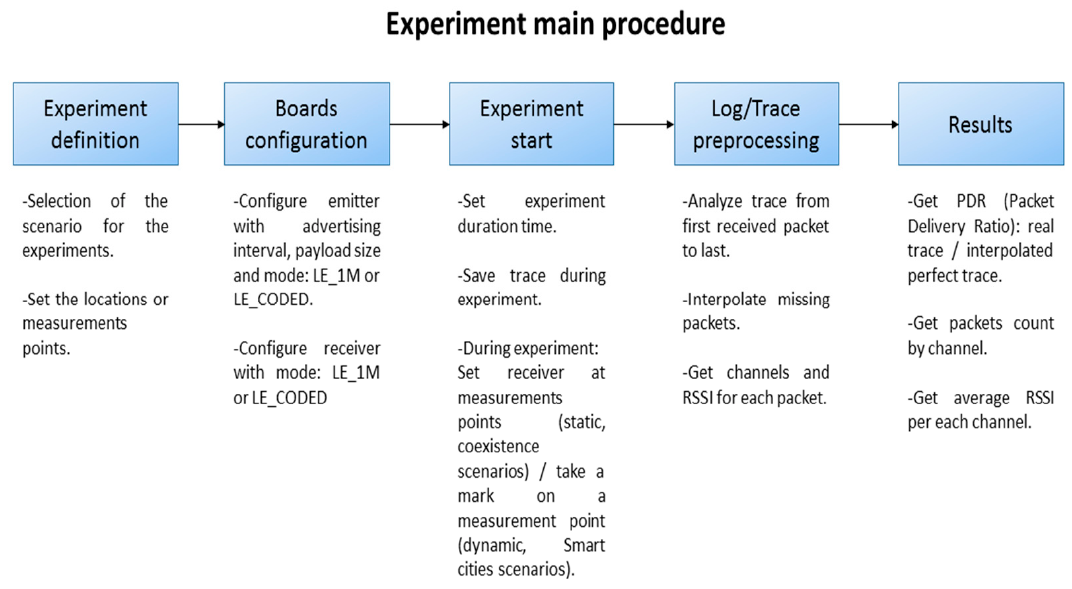
Figure 8. Main methodology done for each experiment.